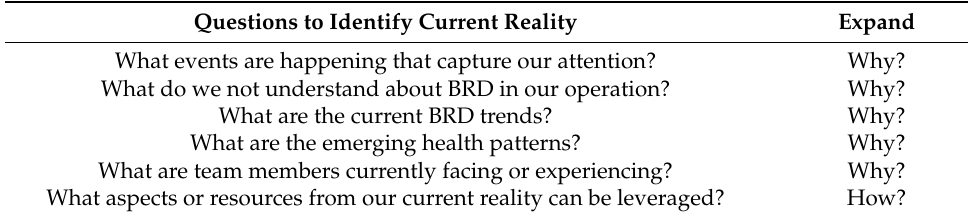
Table 1. Probing questions to consider when identifying the current reality of a complex problem.